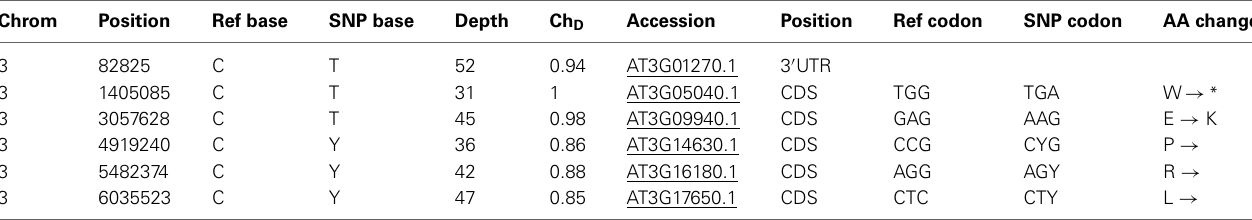
Table 1 | NGM annotation for parental SNP filtered .emap